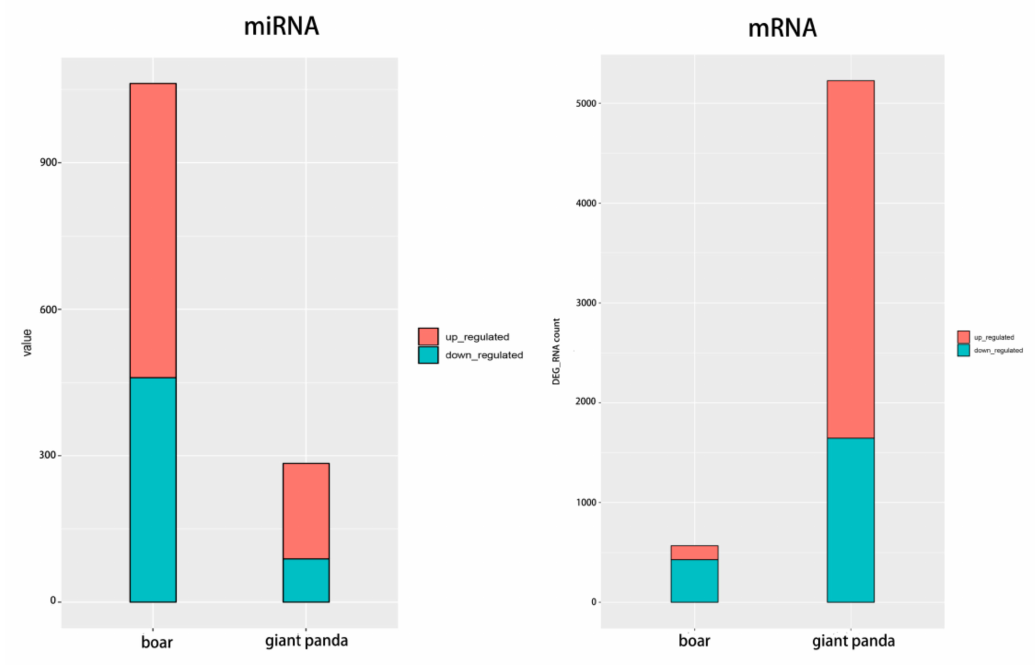
Figure 2. Comparison of the regulation of di ff erentially expressed (DE) miRNAs and mRNAs in boar and giant panda sperm based on high throughput